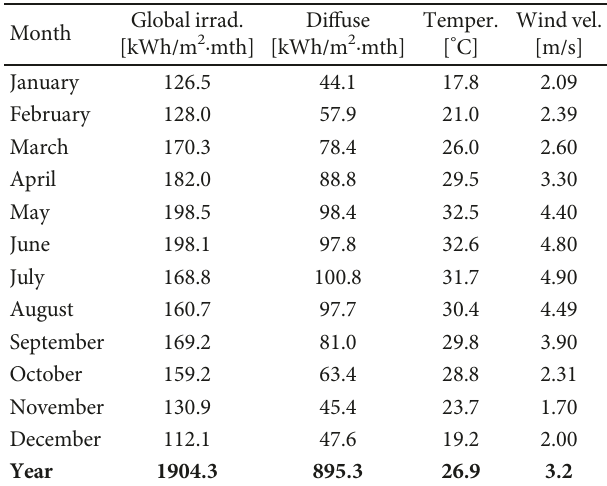
Table 2: Monthly values of Meteonorm 7.1 [2001 – 2010] sat=56% database.